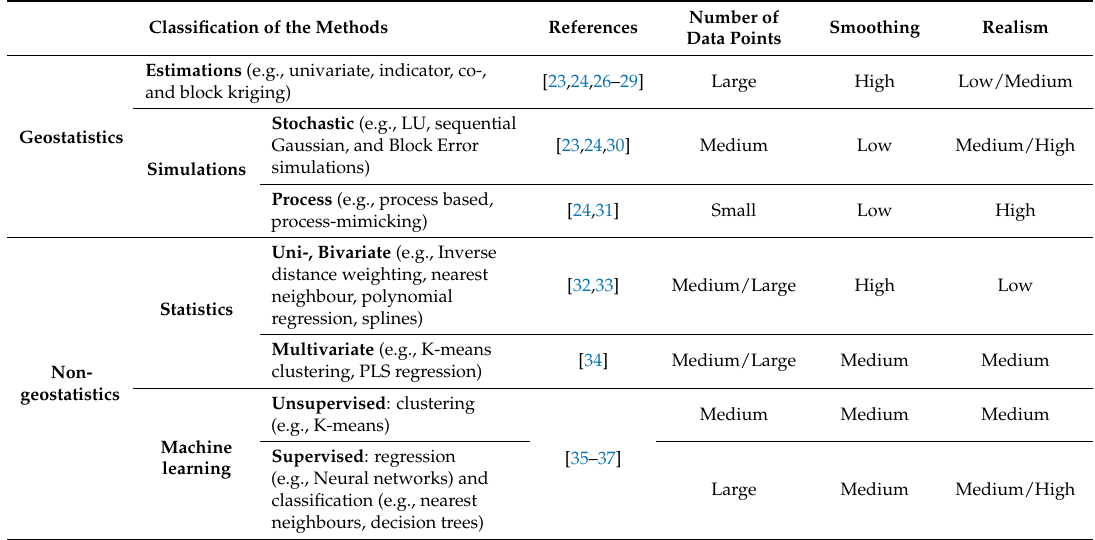
Table 1. Listing of spatial modelling